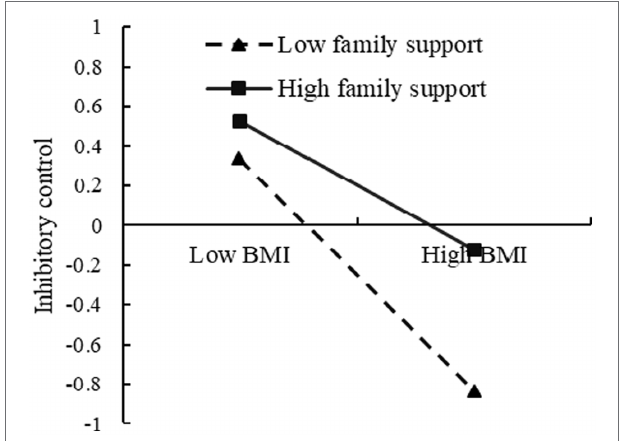
FIGURE 7 | The moderating effect of the family support on the relationship between BMI and inhibitory control.